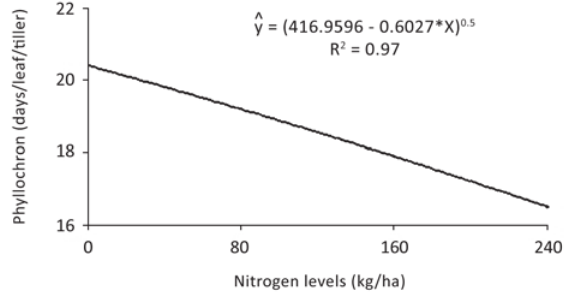
Figure 2 - Phyllochron rate of the B. brizantha cultivars in function of increasing nitrogen rates. (*P <